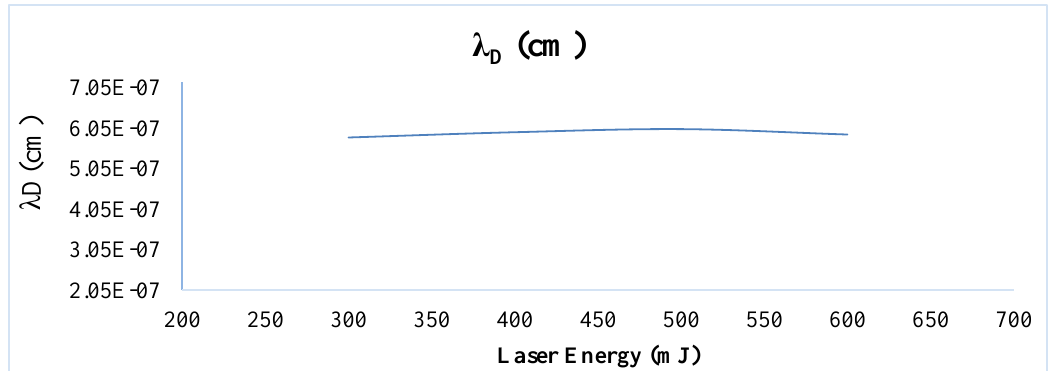
Figure 9: The determination of Debye length (λ